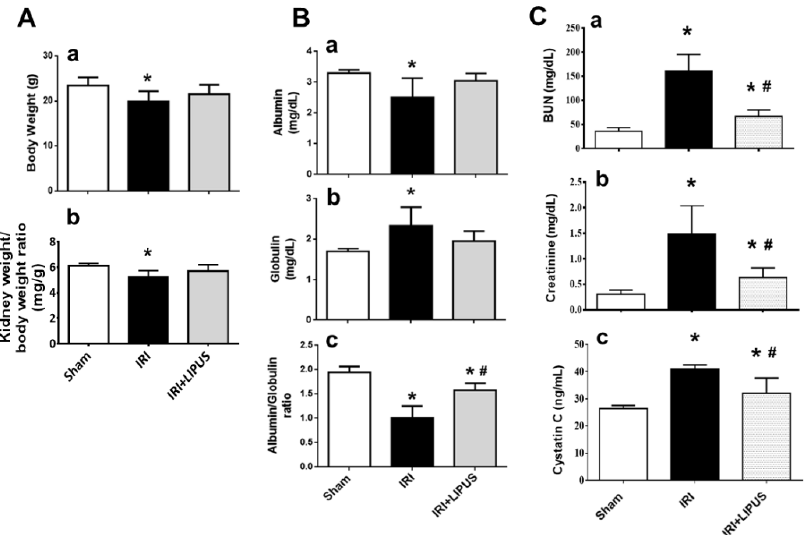
Figure 1. The effects of LIPUS on body weight, kidney weight, and serum biochemistry following unilateral IRI via contralateral nephrectomy on CKD mouse models (the mice were euthanized 14 days after IRI): ( A ) body weight (a) and kidney weight (b); ( B ) serum albumin levels (a), globulin levels (b), and albumin/globulin ratio (c); ( C ) serum blood urea nitrogen levels (BUN, a), creatinine levels (b), and cystatin C levels (c). Data are presented as mean ± SD (n = 8): * p < 0.05 versus the control group; # p < 0.05 versus the CKD-alone group.